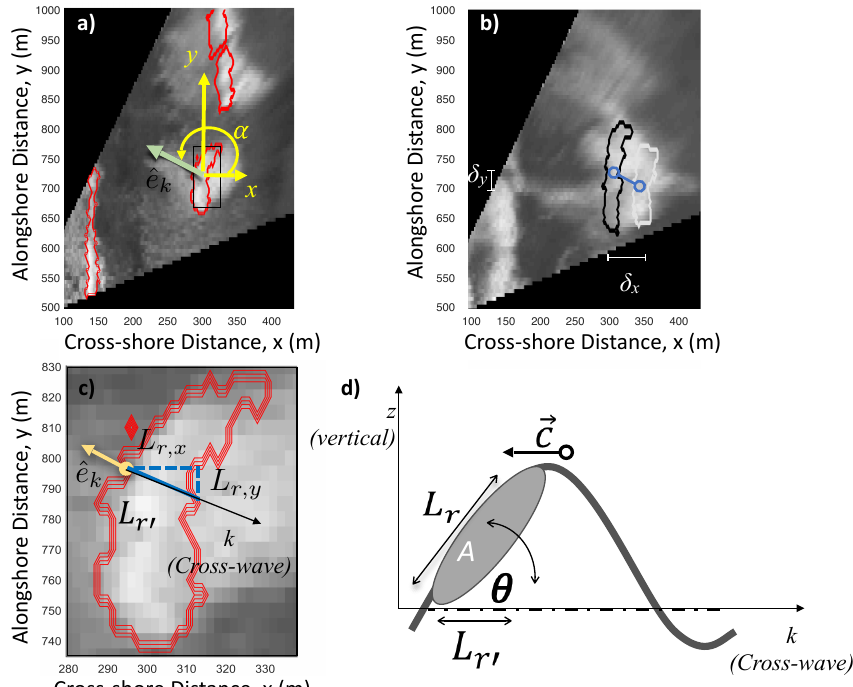
Figure 2. Definition of relevant geometric variables. ( a ) Global reference system orientation and propagation angle definition; ( b ) Example of the centroid tracking among two instances of the same roller. In blue, the displacement of the centroid is presented schematically, along with its components in the global reference system; ( c ) Local reference system and planform roller parameters. ( d ) Schematic of the roller geometry and parameters, defined in the local reference